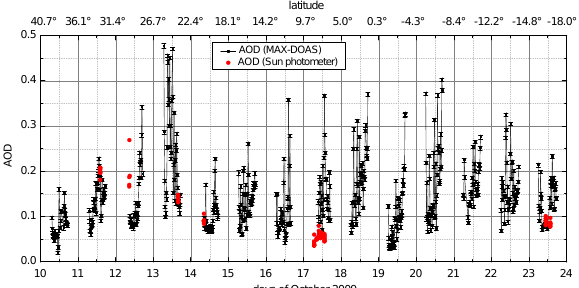
Fig. 4. Comparison of the aerosol optical depth (AOD) at 360nm re- Fig. 4: Comparison of the aerosol optical depth (AOD) at 360 nm retrieved from MAX- trieved from MAX-DOAS (black squares) and from Sun photome- DOAS (black squares) and from Sun photometer (red circles) measurements. The Sun ter (red circles) measurements. The Sun photometer data were con- photometer data were converted from AODs measurements at 440 nm to AODs at 360 nm , verted from AODs measurements at 440nm to AODs at 360nm, using the ˚Angstrom exponents derived from the Sun photometer measurements. using the ˚Angstrom exponents derived from the Sun photometer